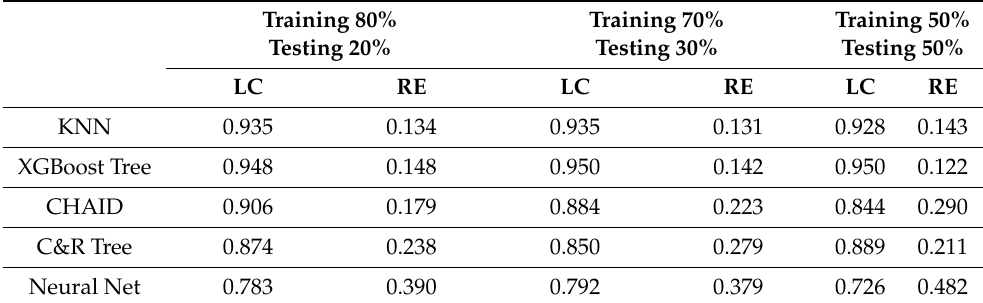
Table 3. Evaluation metrics of the five best algorithms for speed prediction.